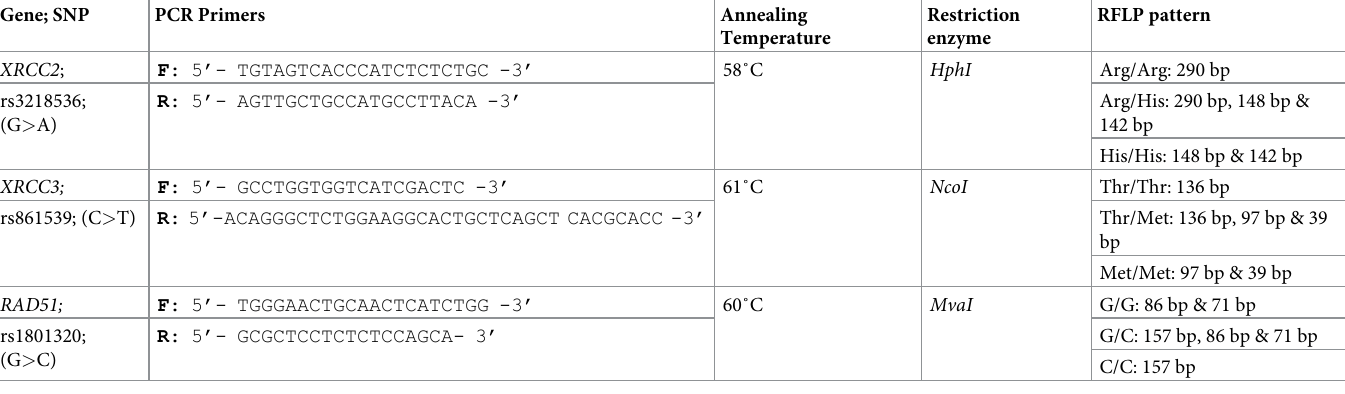
Table 1. PCR conditions, PCR primers and RFLP